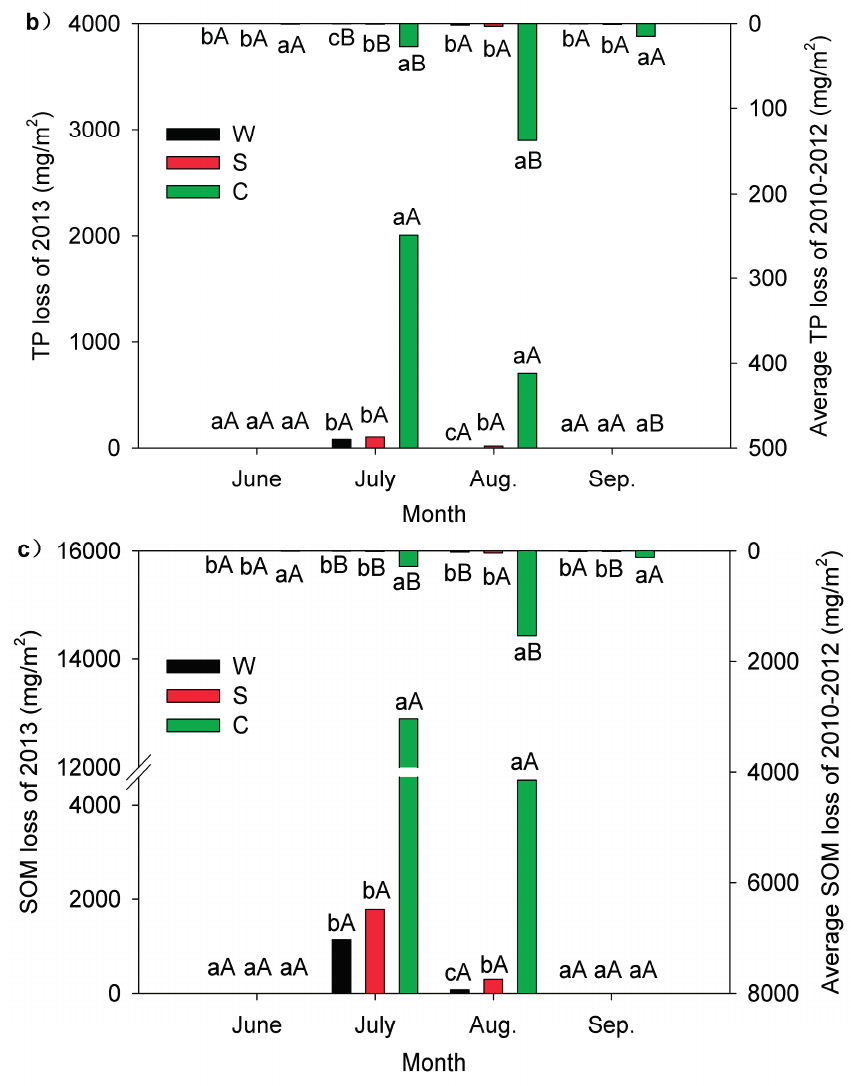
Figure 8. Monthly nutrient losses in the “extreme year” and “normal year”. ( a ) TN loss; ( b ) TP loss; ( c ) SOM loss. The capital and lower-case letters represent the significance of the difference ( p < 0.05) as those in Figure